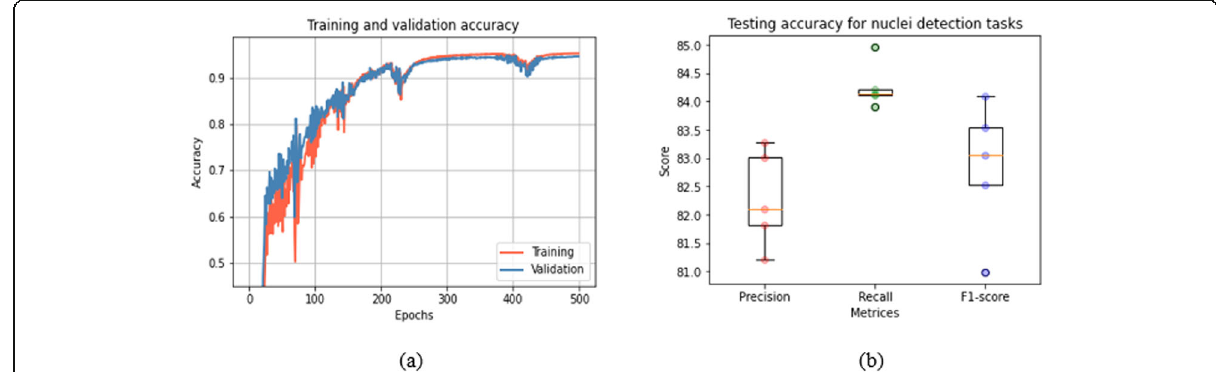
Fig. 14 Results: (a) Training and validation accuracy and (b) Testing precision, recall, and F1-score of UD-Net model for nuclei detection